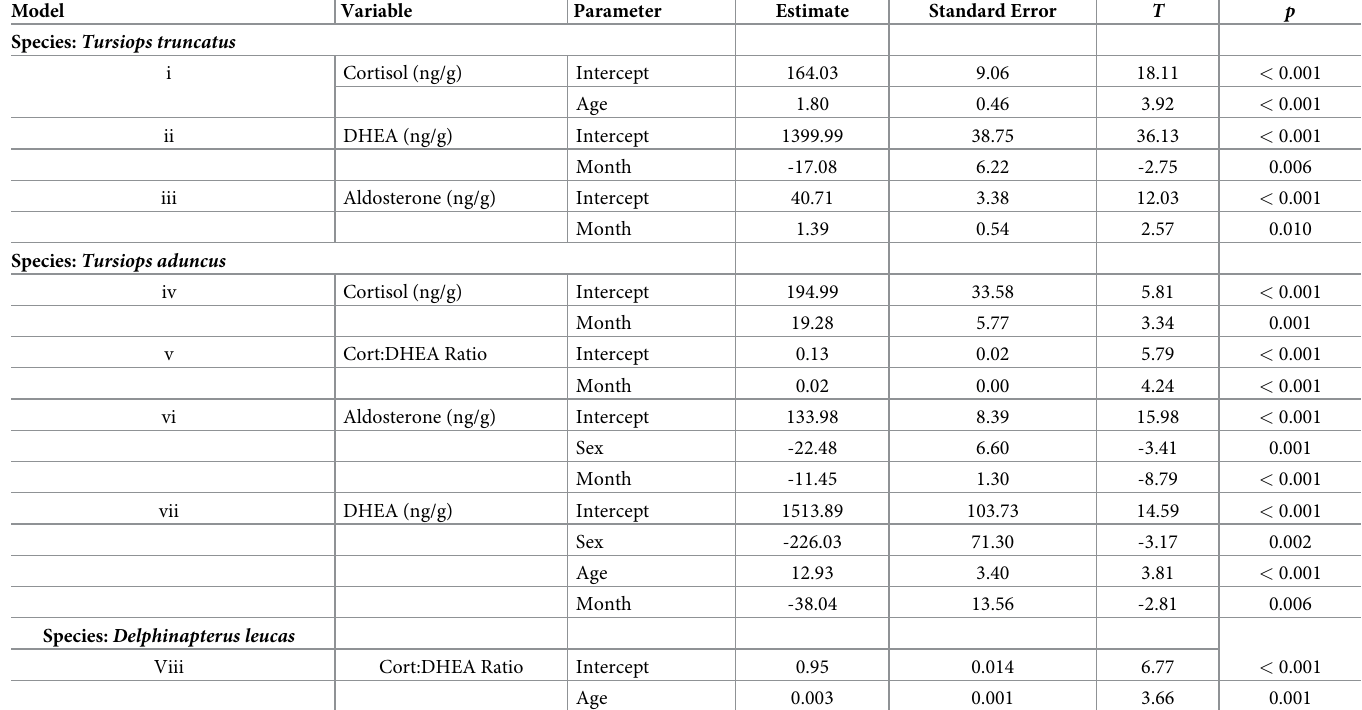
Table 4. Model estimates for predicting fecal hormone values. Linear regression models included the explanatory variables found to be significant predictors. Possible fixed factors included: sex, age, age 2 , and month.